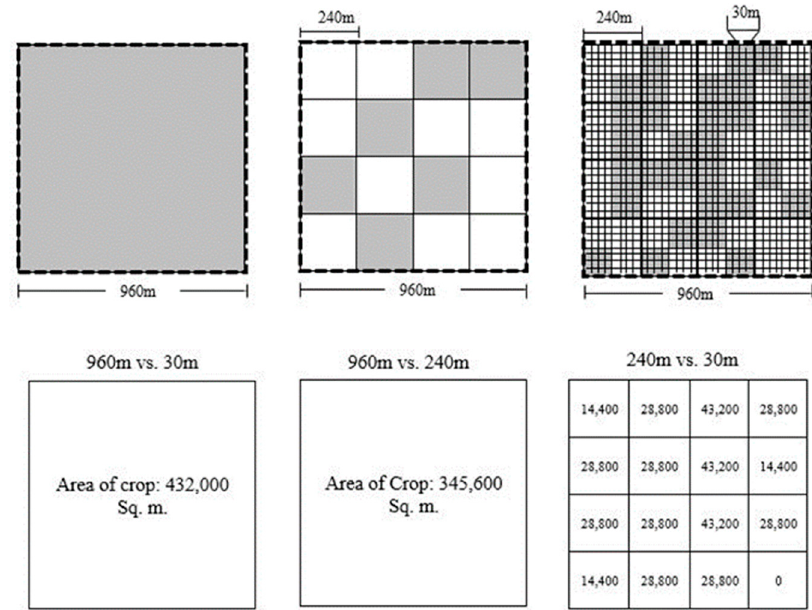
Figure 4. The implementation scheme of similarity matrix to compare the area of cropland on different resolution maps.